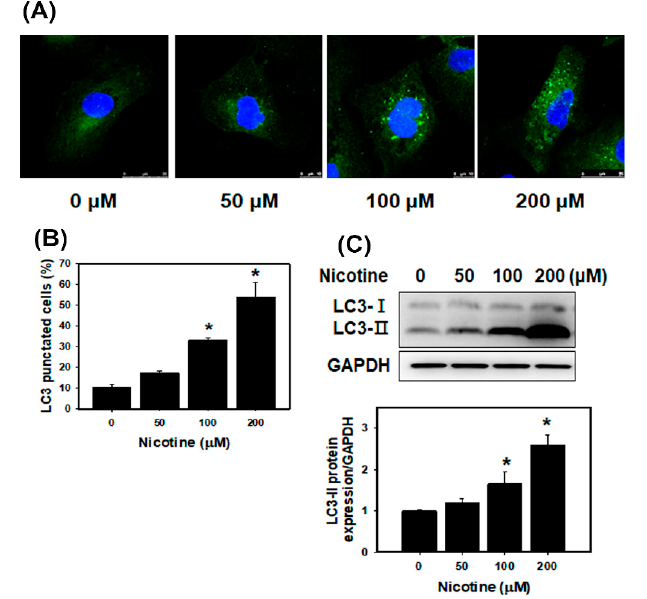
Figure 4. Measurement of autophagy in HK-2 cells that received nicotine treatments. ( A ) Confocal immunofluorescence microscopic imaging of LC3 following 24 h treatment with nicotine. ( B ) Quantification of punctate LC3 staining. * p < 0.05 compared with the control. ( C ) The protein levels of LC3 in the HK-2 cells treated with nicotine. The cells were treated with the various concentrations of nicotine for 24 h. The LC3-II protein expression of the histogram represents the average normalized densitometric values. GAPDH was used as the internal control. Data are presented as the means ± standard deviation of three independent experiments. * p < 0.05 compared with the control. Statistical significance was estimated with ANOVA by Dunnett’s multiple comparison